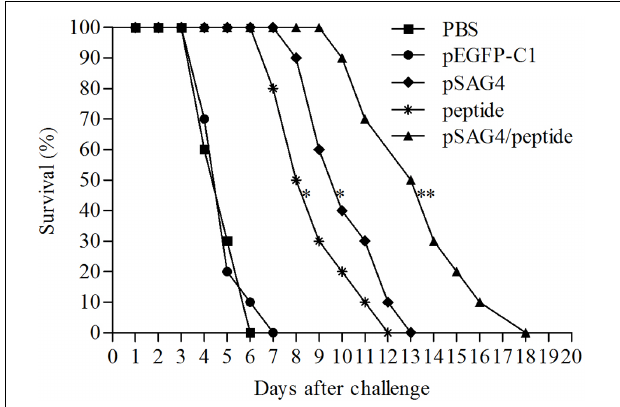
FIGURE 6 | Survival curves of vaccinated BALB/c mice against T. gondii infection. The five groups of mice were challenged with 1 × 10 4 tachyzoites of virulent T. gondii RH strain 2 weeks after the last immunization. Each group was composed of 10 mice and survival time was monitored daily for 17 days after challenge. ∗ Compared with PBS or pEGFP-C1, p < 0.05 and ∗∗ compared with pSAG4 or peptide, p < 0.05.